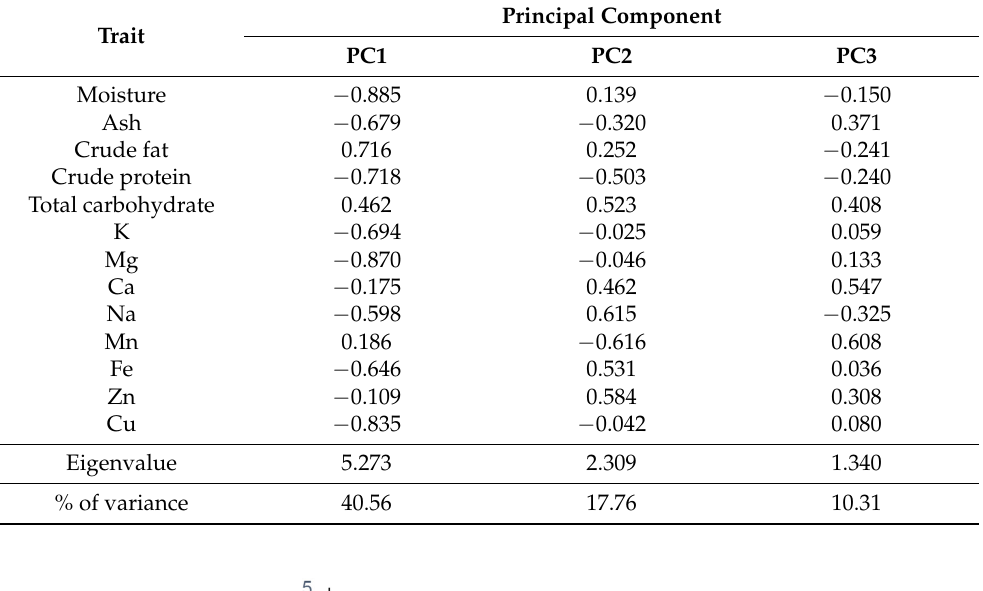
Table 5. Pearson’s correlation coefficients between 13 chemical traits and scores of the first three principal components.